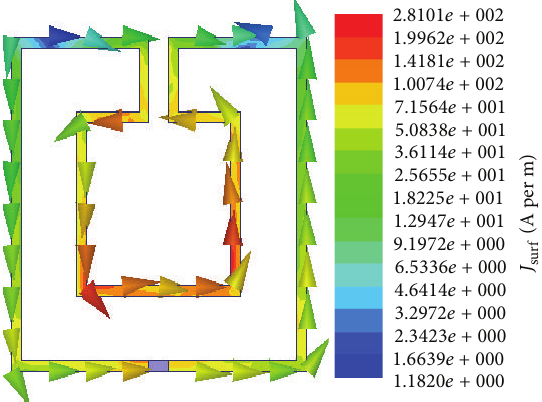
Figure 5: Simulated current distribution on the antenna.